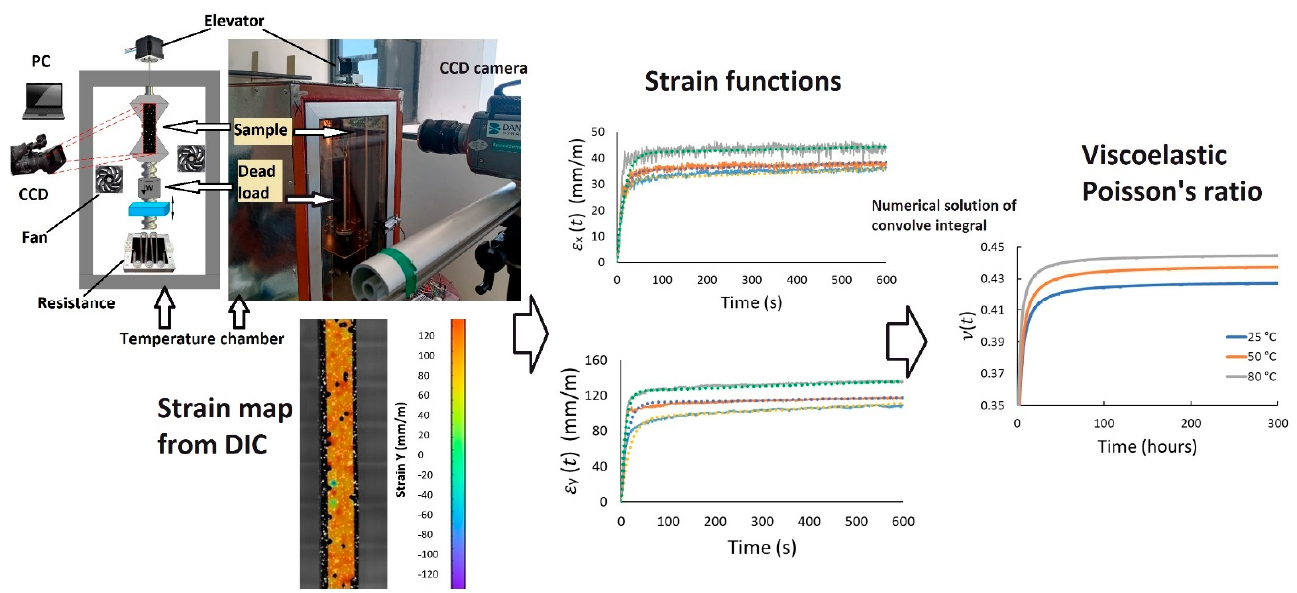
Figure 1. Experimental setup and methodological steps for determining viscoelastic Poisson’s ratio of elastomers.